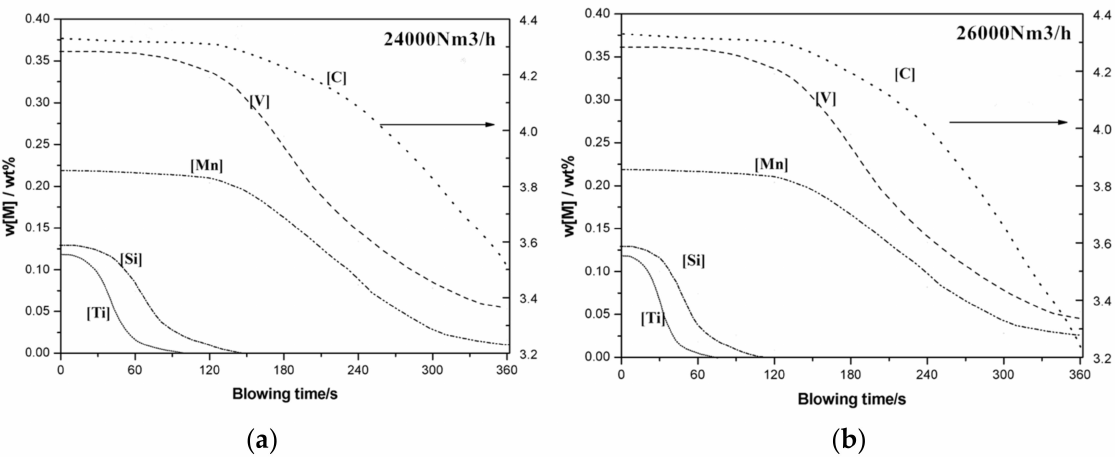
Figure 4. Effect of oxygen flow rate on vanadium extraction refining. ( a ) 24,000 Nm 3 /h ( b ) 26,000 Nm 3